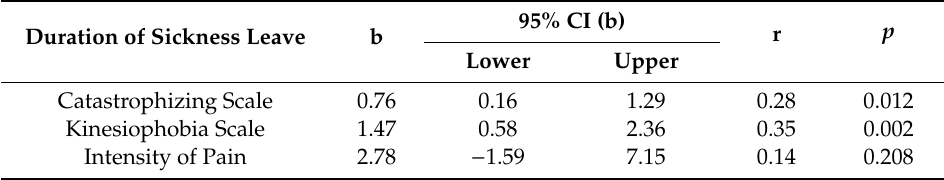
Table 4. Association of the duration of absence variable with the clinical variables analyzed in this study, controlling for educational and occupational